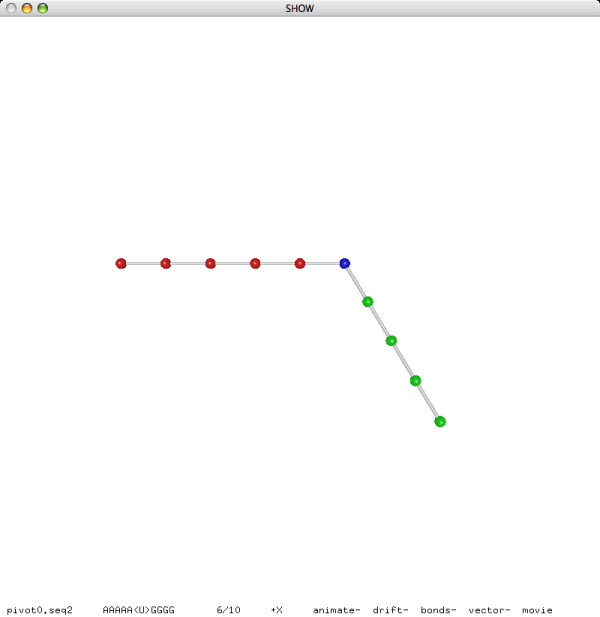
A pivot move (before).